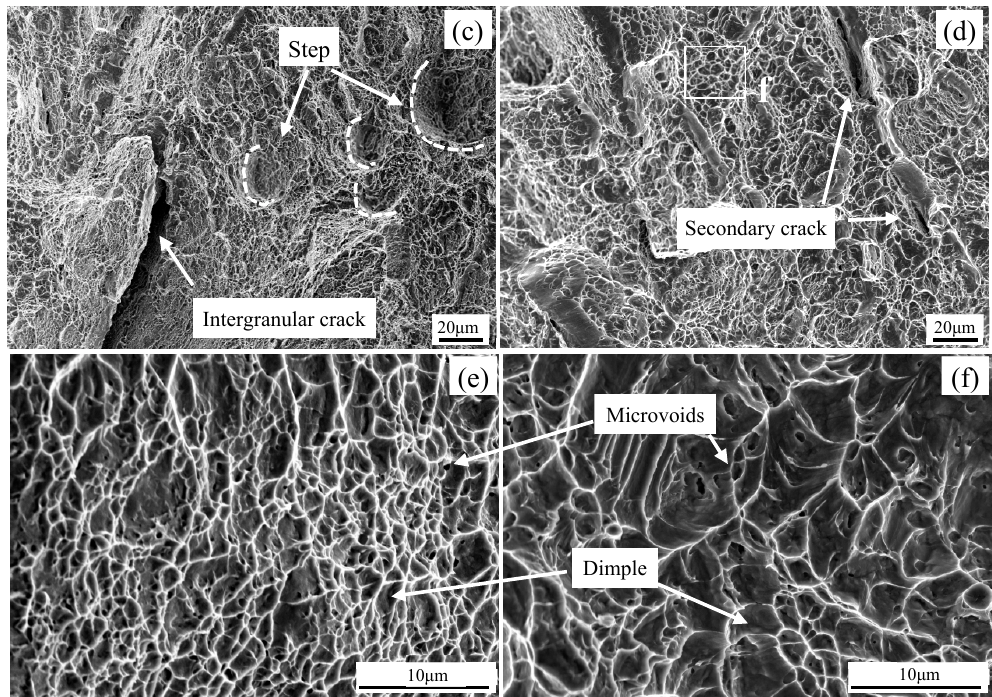
Figure 8. Fractographs of room temperature tensile tested specimen of Ti17 in different aging condition showing: ( a ) ( c ) ( e ) 540 °C; ( b ) ( d ) ( f ) 600 °C.